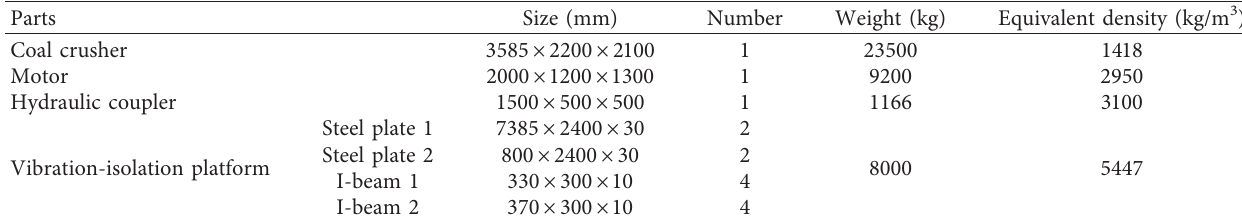
Table 1: Parameters of equipment and platform.